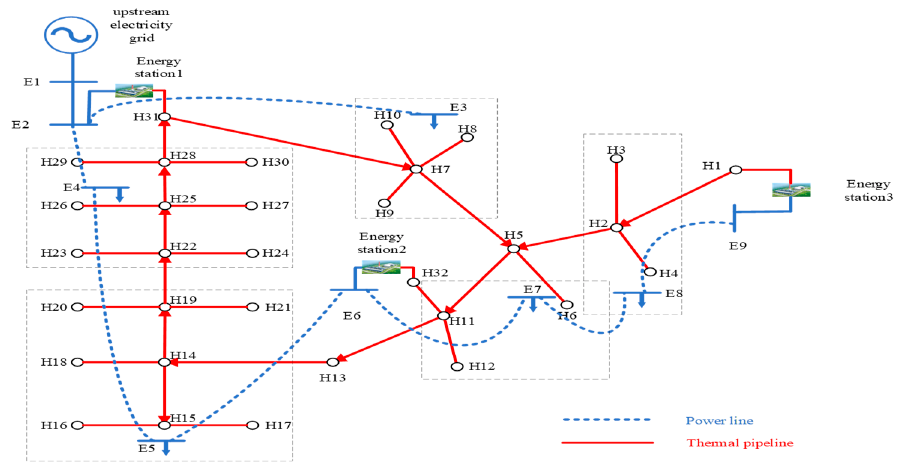
Figure 2. The structure of the case system.